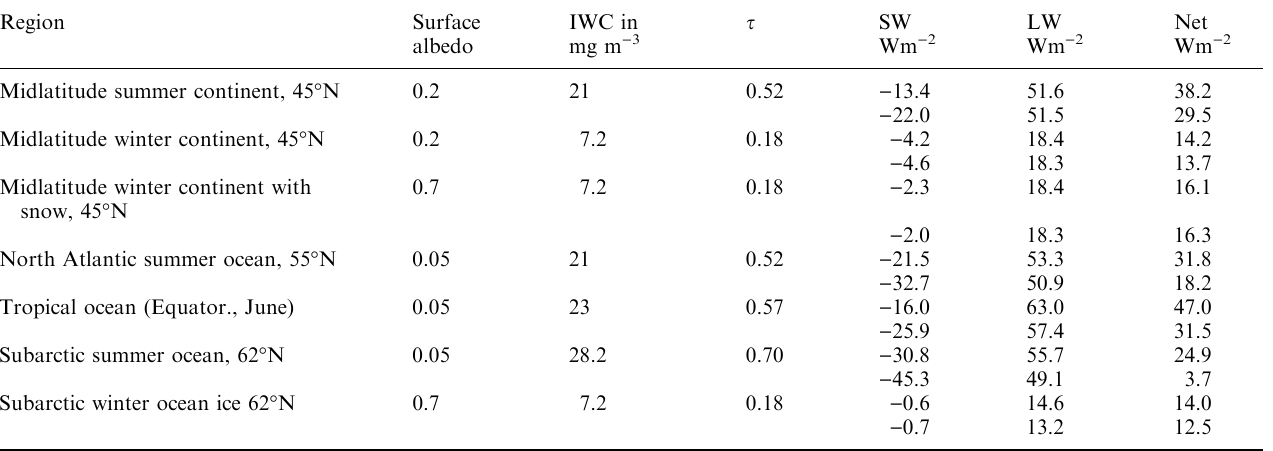
Table 4. Daily mean TOA radiative flux changes for shortwave (SW), longwave (LW), and Net( (cid:136) SW + LW) radiation for 100% contrail cover in various regions and seasons, with prescribed surface albedo, with contrail ice water content IWC, and